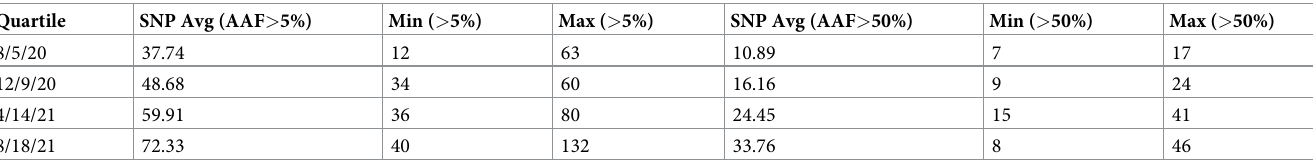
Table 1. Assessment of SNVs at Time Quartiles of the COVID-19 Pandemic. Quartile SNP Avg (AAF >